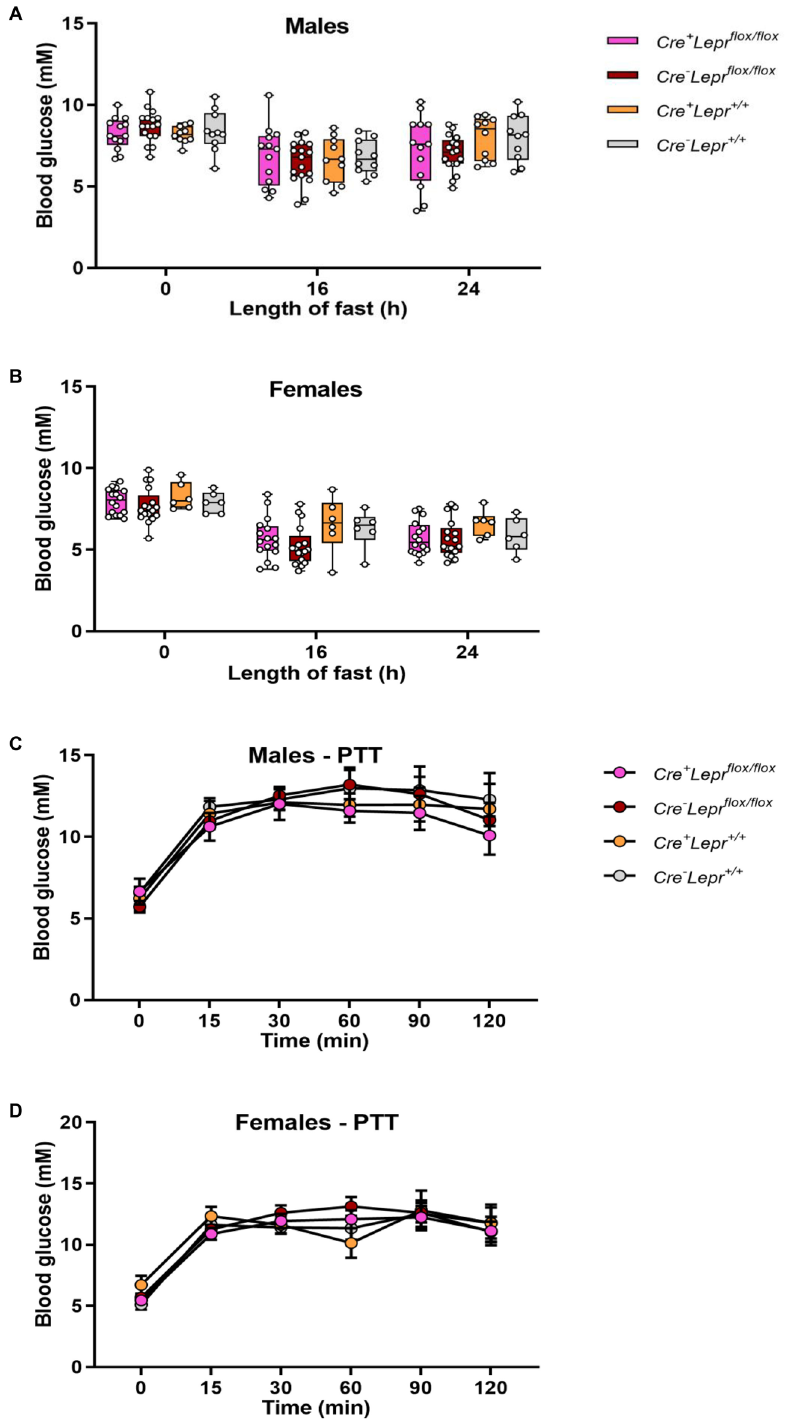
Figure 10. Blood glucose at different fasting times ( A , B ) and pyruvate tolerance tests (PTTs) ( C , D ) in mice from the Lepr knockdown study. In ( A ), n = 13 for Cre + Lepr flox/flox , n = 17 for Cre − Lepr flox/flox , n = 10 for Cre + Lepr + / + , and n = 10 for Cre − Lepr + / + . In ( B ), n = 16 for Cre + Lepr flox/flox , n = 17 for Cre − Lepr flox/flox , n = 6 for Cre + Lepr + / + , and n = 6 for Cre − Lepr + / + . In ( C ), n = 13 for Cre + Lepr flox/flox , n = 17 for Cre − Lepr flox/flox , n = 8 for Cre + Lepr + / + , and n = 9 for Cre − Lepr + / + . In ( D ), n = 16 for Cre + Lepr flox/flox , n = 17 for Cre − Lepr flox/flox , n = 5 for Cre + Lepr + / + , and n = 6 for Cre − Lepr + / + . Performed repeated measures two-way ANOVA with post-hoc analysis. Main effect of time (p < 0.05) in ( A – D